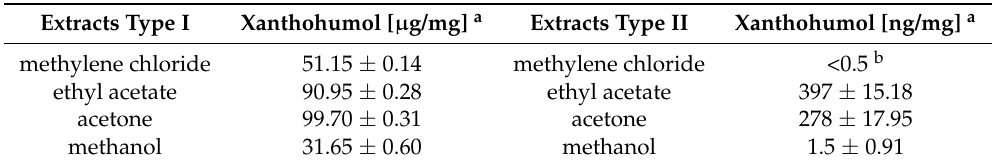
Table 1. The content of xanthohumol ( 1 ) achieved by HPLC in the investigated spent hops extracts type I (obtained by solvent extraction) and type II (obtained from extracts type I by the removal of 1 ).